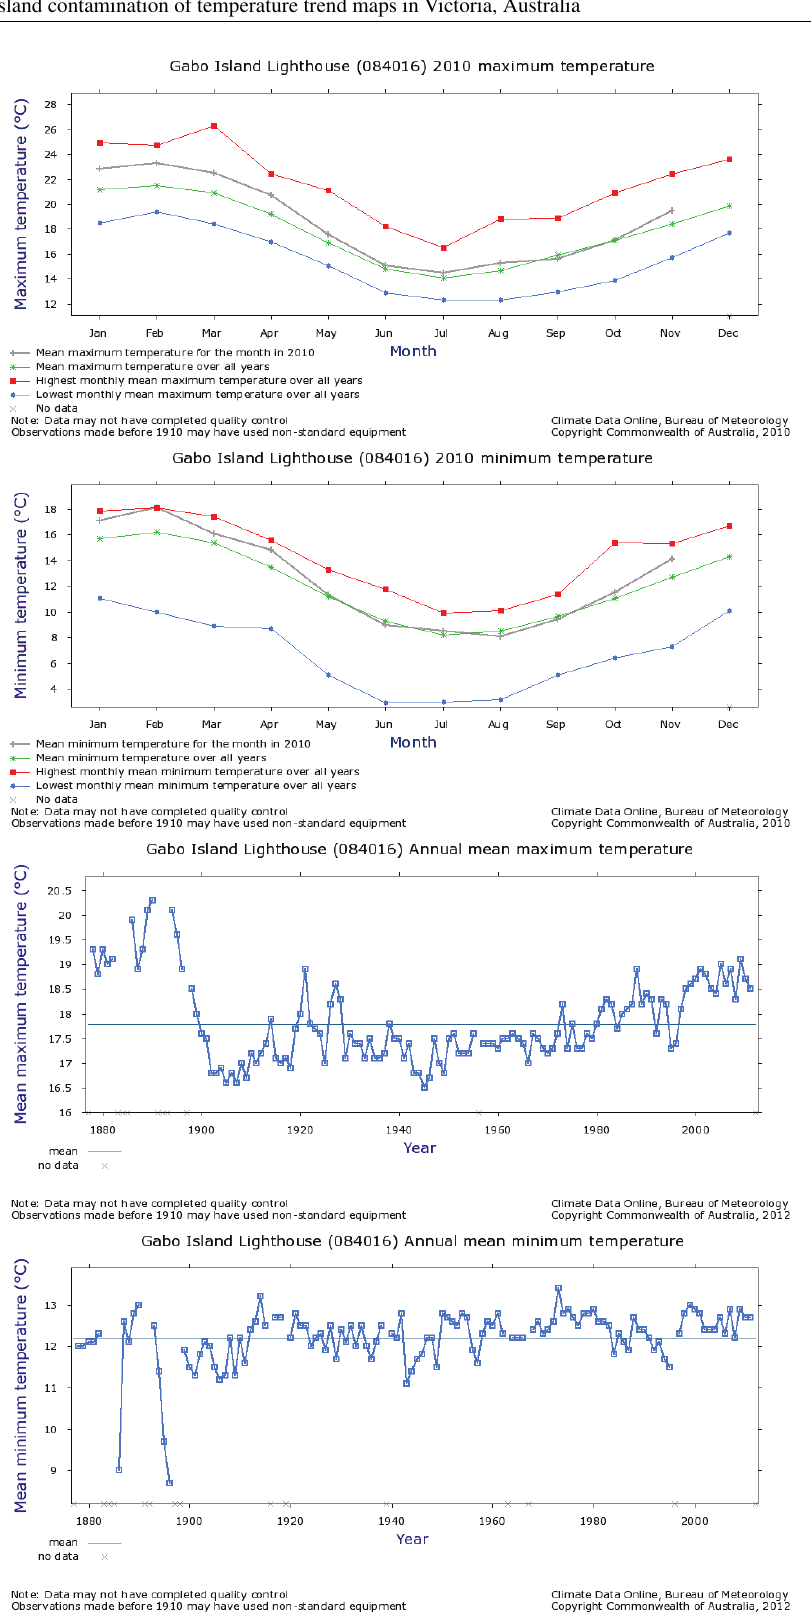
Figure 19. Australian Government Bureau of Meteorology temperature graphs for historical locations in Victoria, Aus-